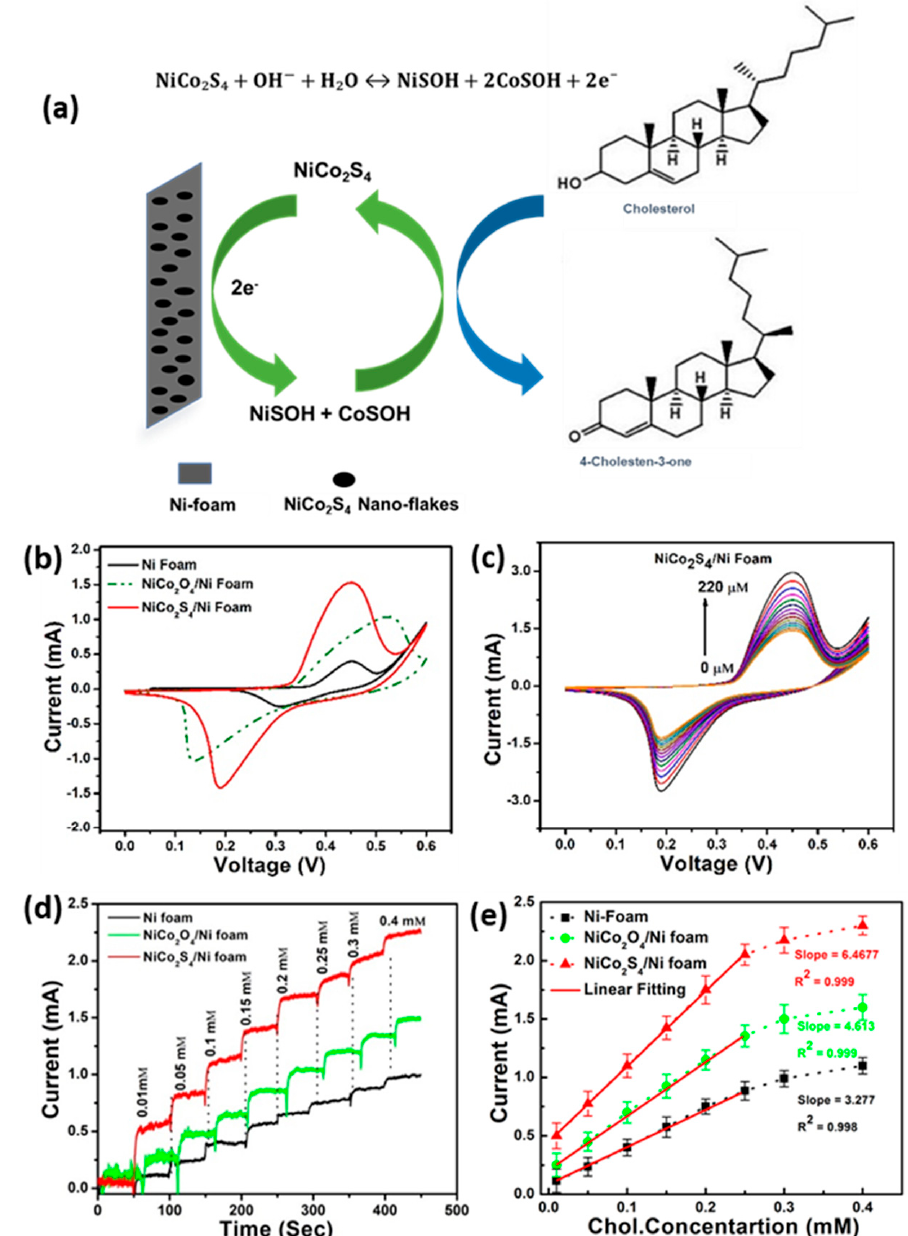
Figure 6. ( a ) Schematic illustration of NiCo 2 S 4 @NF electrode for the measurement of cholesterol. ( b ) Comparative CV response of Ni foam, NiCo 2 O 4 @NF and NiCo 2 S 4 @NF electrodes with the addition of 10 µm cholesterol. ( c ) CV response of NiCo 2 S 4 @Ni-foam electrodes under different concentra- tions of cholesterol. (d) Comparative amperometric response of Ni foam, NiCo2O4@Ni-foam and NiCo2S4@Ni-foam electrodes with different concentrations of cholesterol at +0.45 V. ( e ) The cali- bration plots corresponding to amperometric response. Reprinted with permission from Ref. [58].